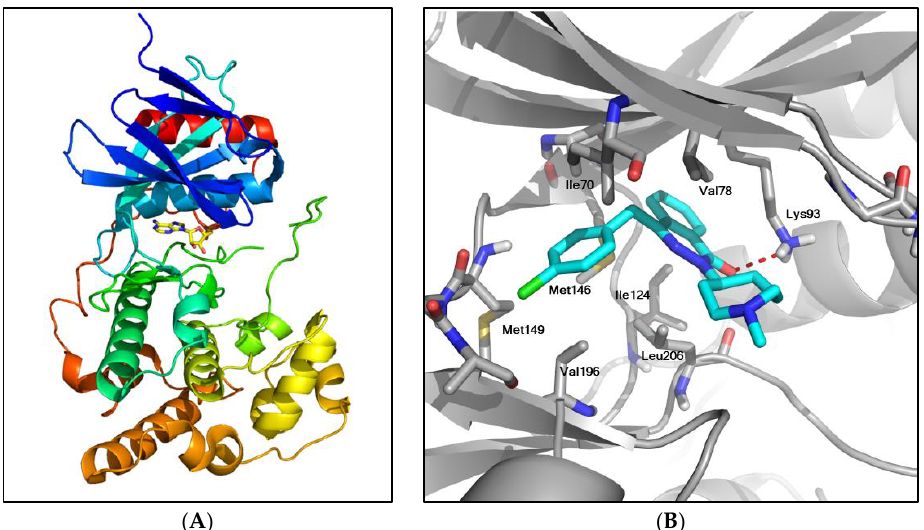
Figure 1. Crystal structure of JNK3 and the structure of JNK3 bound to Aze. ( A ) Overall crystal structure of JNK3 (PDB 4KKE). The bound AMP is displayed as a yellow stick. ( B ) The lowest energy structure of Aze bound to JNK3. JNK3 is displayed as a gray cartoon and Aze as cyan sticks. A hydrogen bond is presented as a red broken line, and the residues in close contact with Aze are highlighted as gray sticks.